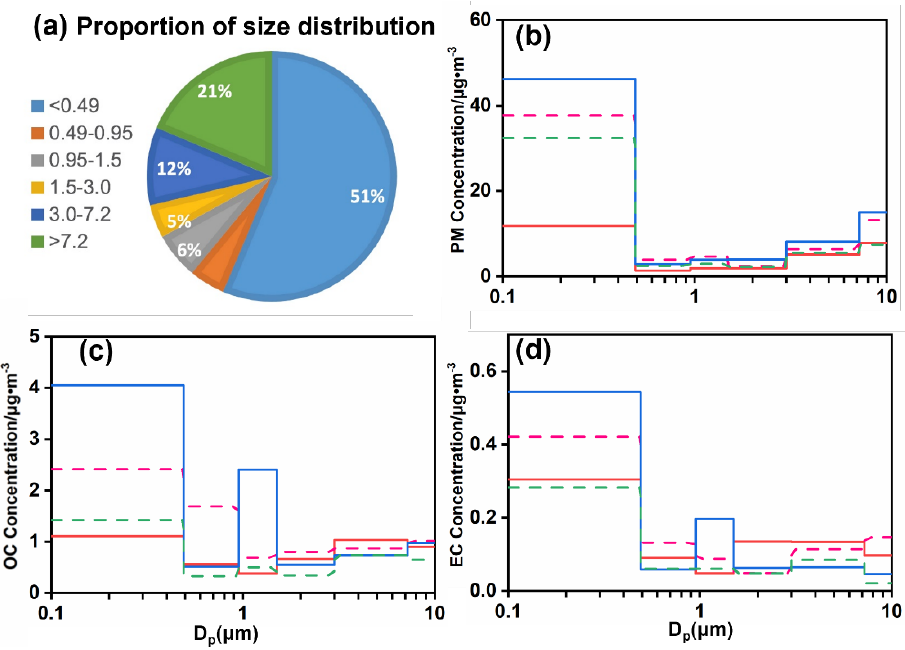
Figure 2. Concentration size distribution during different seasons: ( a ) proportion; ( b ) PM; ( c ) OC; and ( d ) EC. ((green line — spring, red line — summer, pink line — autumn and blue line — winter)